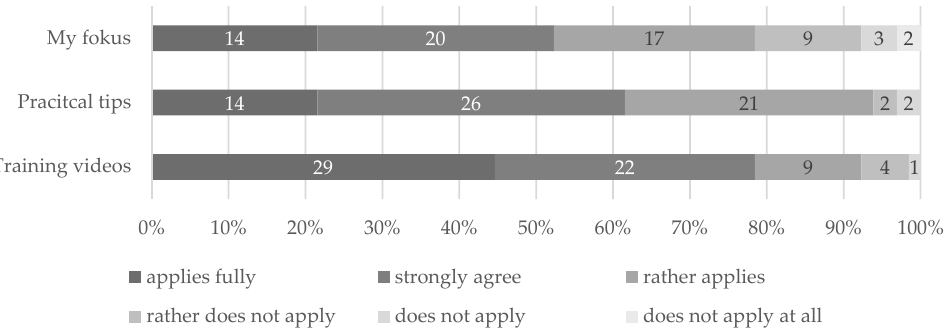
Figure 2. Motivation for long-term usage of app components at the end of the intervention. Notes: presentation in percentages.